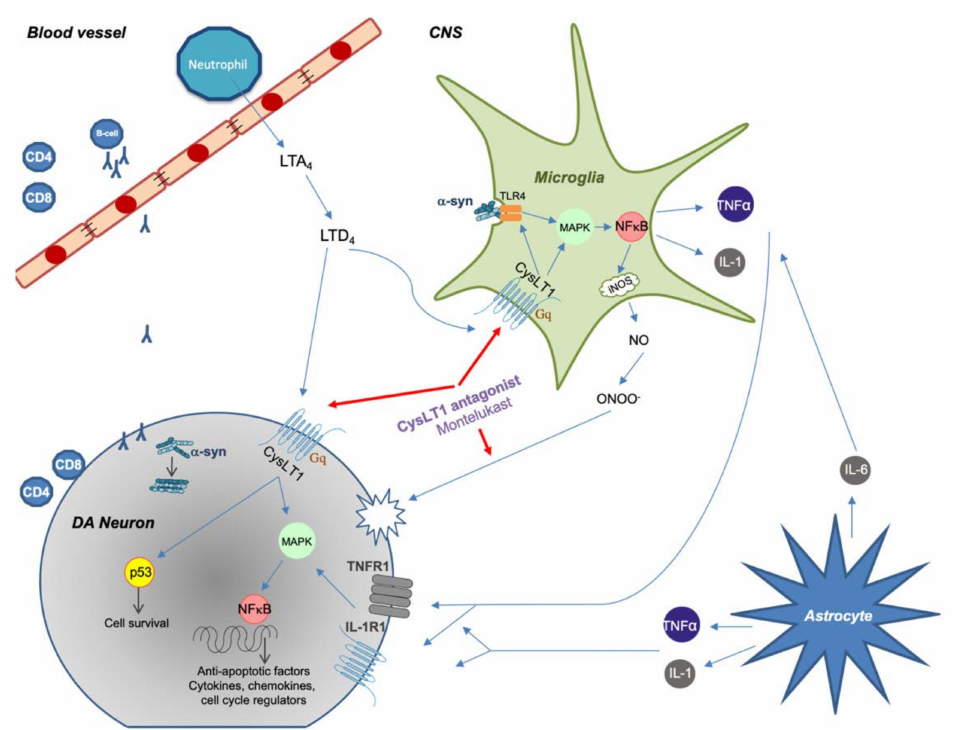
Figure 1. Summary of proposed immune system involvement in Parkinson’s disease (PD) with an emphasis on CysLT signaling. Peripheral immune cells are activated and can enter the CNS during pathological conditions. Misfolded α -synuclein in the CNS or periphery can trigger CD4 and CD8 T-cell recruitment with direct neuronal cell death as a consequence. α -synuclein can also activate microglia through TLR4-mediated phagocytosis, which causes an increased inflammatory response through NF- κ B signaling. Astrocytes react to tissue damage and further enhance inflammatory response through production of cytokines. CysLTs increases inflammatory response by binding to CysLT 1 receptor, thus further increasing microglial activity. CysLT 1 on DA neurons can trigger apoptosis by upregulating p53 gene. Montelukast decreases inflammation by inhibiting CysLT 1 signaling but can also act as an antioxidant by binding directly to reactive nitrogen